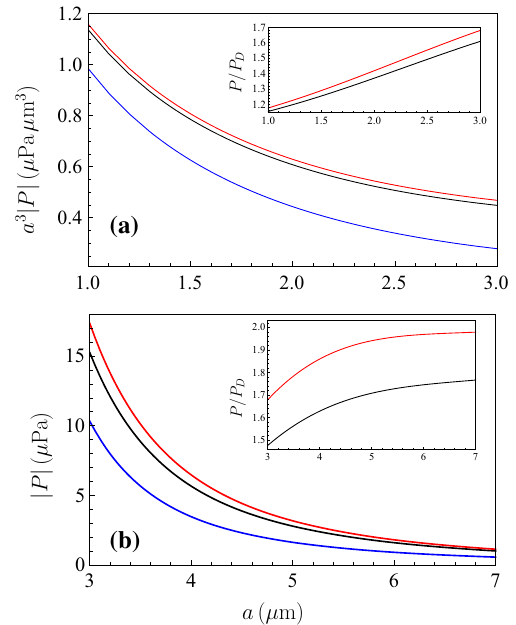
Fig. 1 The magnitudes of the Casimir pressure a multiplied by a 3 and b on their own, computed using the standard Drude, P D , the alternative nonlocal, ˜ P D , and the plasma, P p , responses are shown as functions of separation by the bottom, middle, and top lines, respectively. In the insets, the ratios ˜ P D / P D and P p / P D are shown by the bottom and top lines, respectively